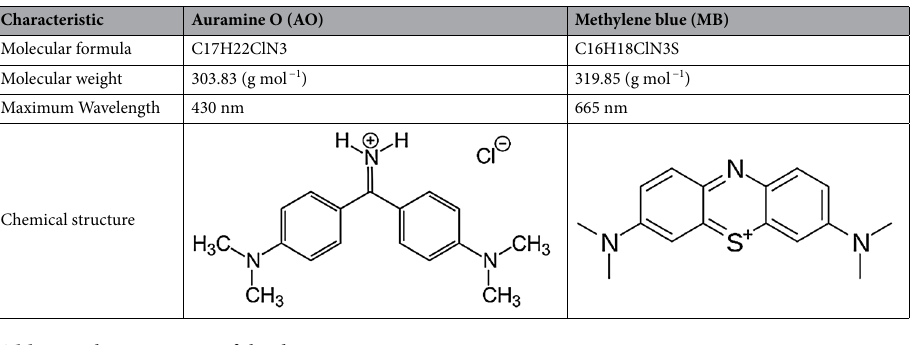
Table 1. Characteristics of the